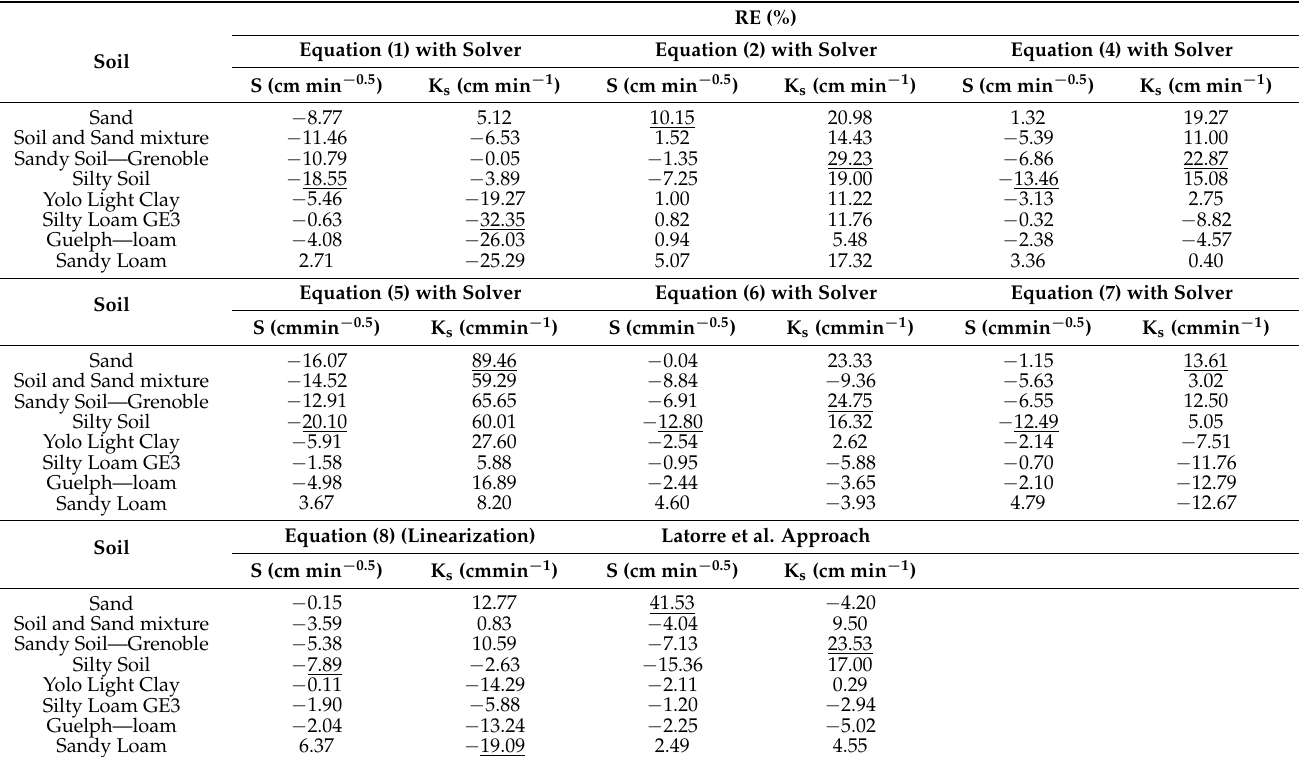
Table 3. Relative errors (RE%) of the predicted values of S and K s obtained from various methods for all soils studied. The underlined values are the maximum relative errors calculated from each